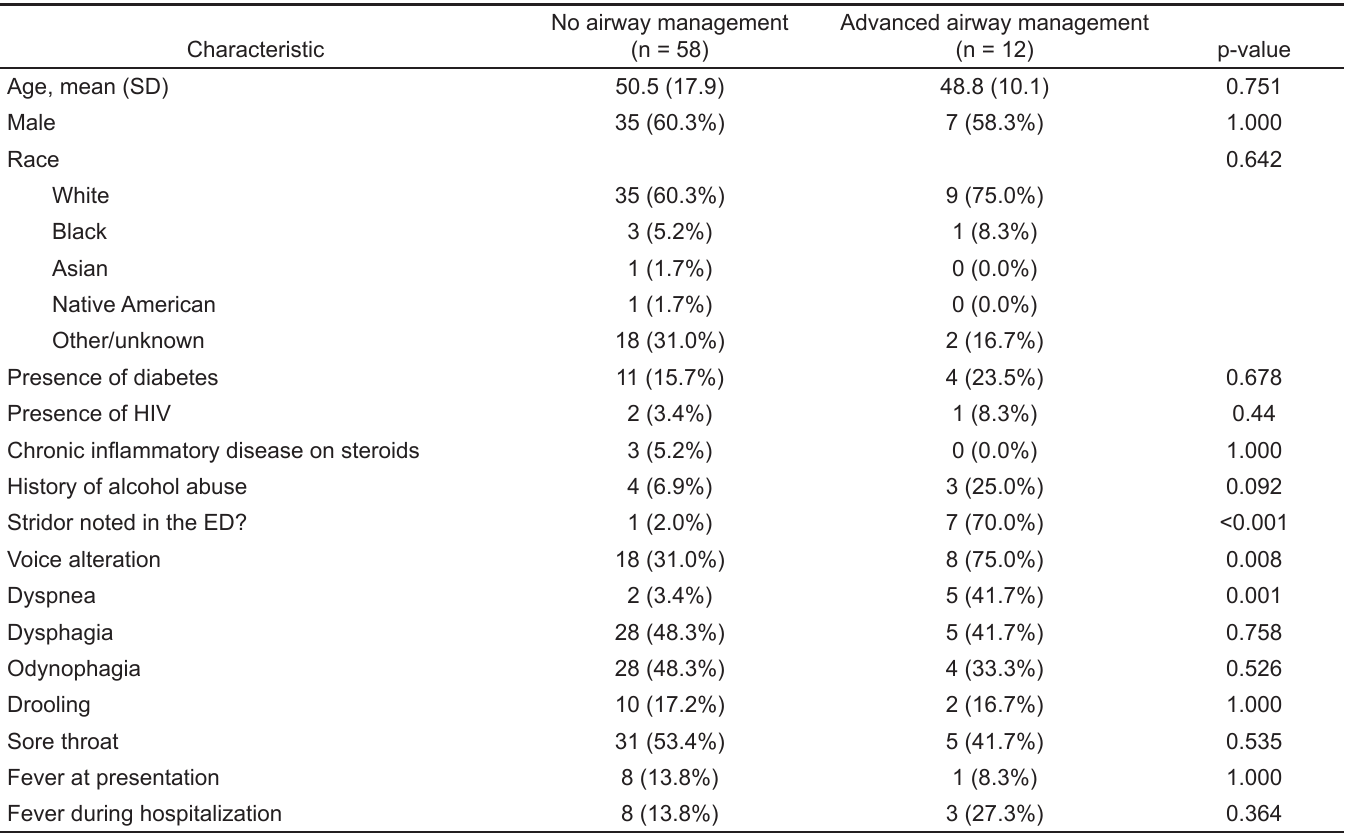
Table 5. Airway management by patient characteristics.